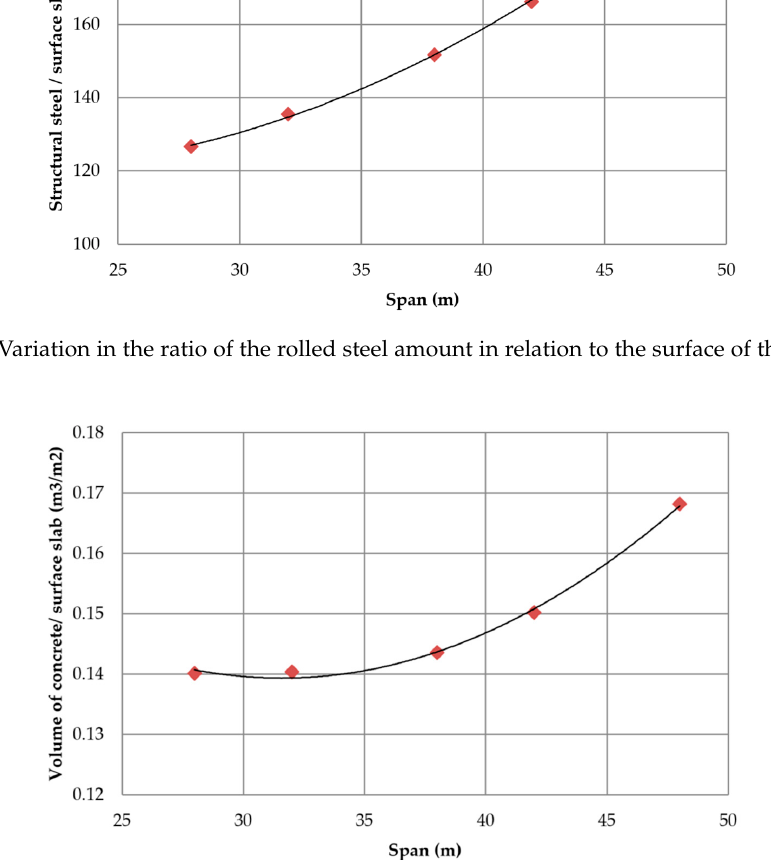
Figure 13. Variation in the ratio of the volume of concrete in relation to the surface of the slab with the span.